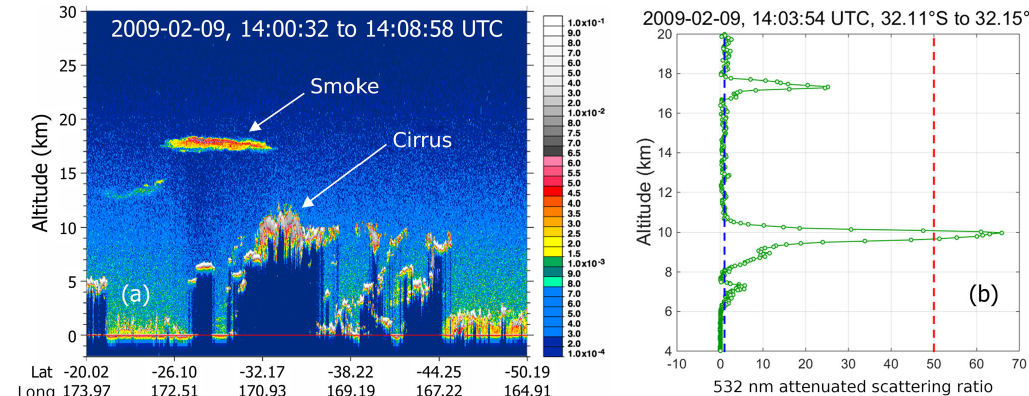
Figure 7. (a) CALIOP 532nm attenuated backscatter coefficients (km − 1 sr − 1 ) showing smoke from the February 2009 Black Saturday fires in Australia lofted over an opaque cirrus deck; (b) a profile of attenuated scattering ratios (in green) for which the cirrus beneath the smoke plume qualifies as a calibration quality cloud in the V3 algorithm. In panel (b) , the blue dashed vertical line indicates an attenuated scattering = 50. Below the high-altitude smoke plume, ratio of 1, while the red dashed vertical line indicates the V3 cloud detection threshold of R (cid:48) 532 = 1 . 25 ± 0.20. / T 2 the ratio of particulate two-way transmittances is T 2 p , 1064 p , 532